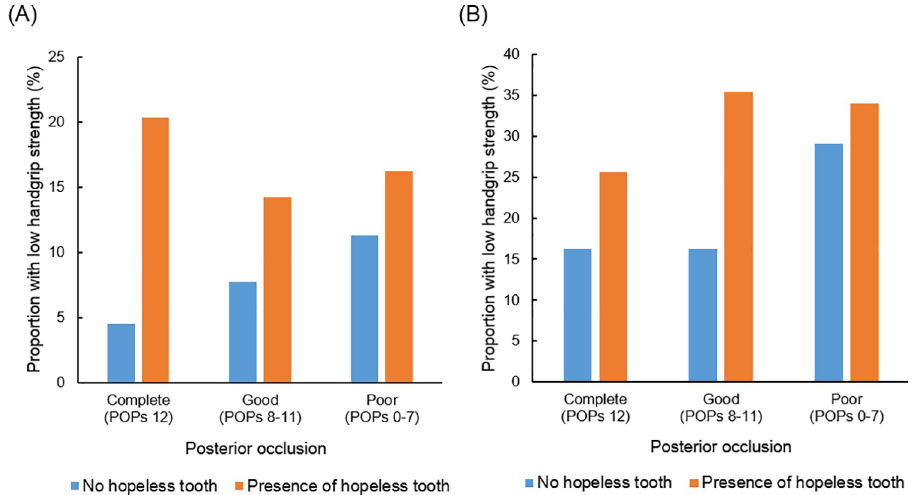
Fig 2. Increased proportion of individuals with low handgrip strength in the presence of a hopeless tooth. Within a similar posterior occlusion, the presence of a hopeless tooth increased the proportion of those with low handgrip strength in both (A) males and (B) females.